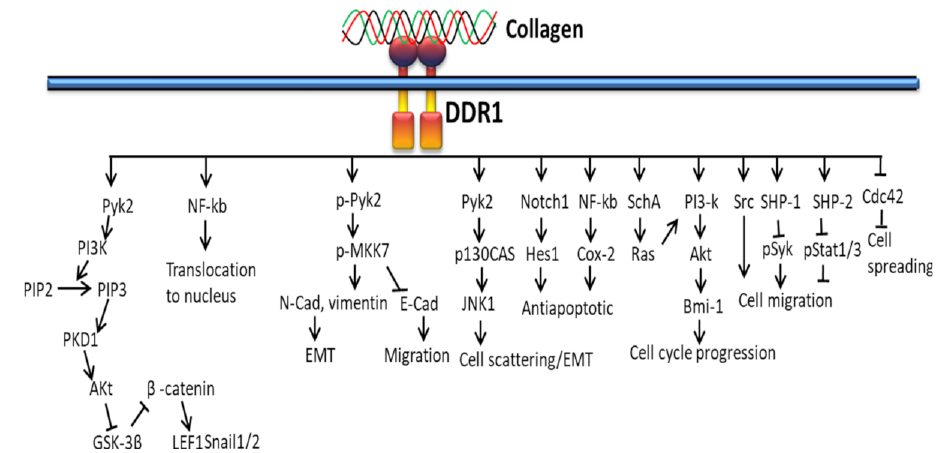
Figure 7. Collagen DDR signals in EMT.